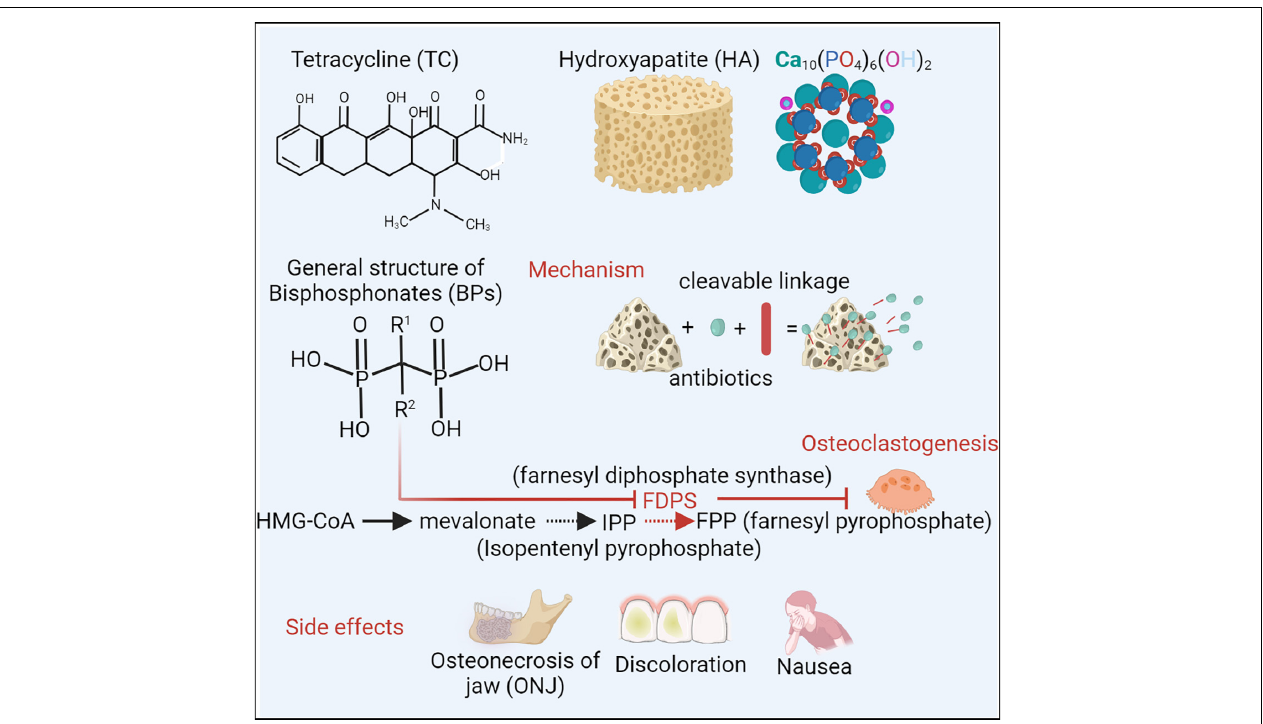
FIGURE 4 | To improve therapeutic efficacy and minimize systematic toxicity, the bone targeting strategies have been applied (Shi et al., 2020). Tetracycline (TC) and its derivative are an important class of broad-spectrum antibiotics. Considering interactions with bone matrix of hydroxyapatite (HA) [Ca 10 (PO 4 ) 6 (OH) 2 ] and chelating with Ca 2 + , TC arouse attractions in skeletal tissues. However, side effects, such as nausea, hypoglycemia, dental discoloration, restrict TC applications as a monotherapy in osteomyelitis (Rusu and Buta, 2021). Bisphosphonates (BPs), (HO) 2 P(O)CR 1 R 2 P(O)(OH) 2 , can also interact with calcium and acquire the specificity of bone affinity. By blocking enzyme farnesyl diphosphate synthase (FDPS), BPs can inhibit FPP (farnesyl pyrophosphate) production and osteoclastogenesis, which subsequently prevents bone loss (Bjelic and Finsgar, 2022). Due to high accumulation in jawbone matrix, BP probably induce a serious complication of osteonecrosis of the jaws (ONJ) (Cheong et al., 2014). Combined with CaP based bone targeting materials, different antimicrobial agents can be conjugated for local administration. Created with